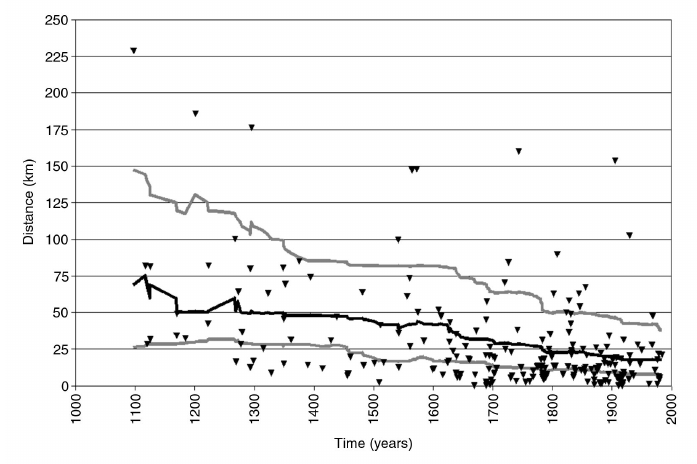
Fig. 3. Individual values of CPND with three percentiles (25%, 50% or median, 75%) calculated from the be- ginning of the catalogue to the n -th